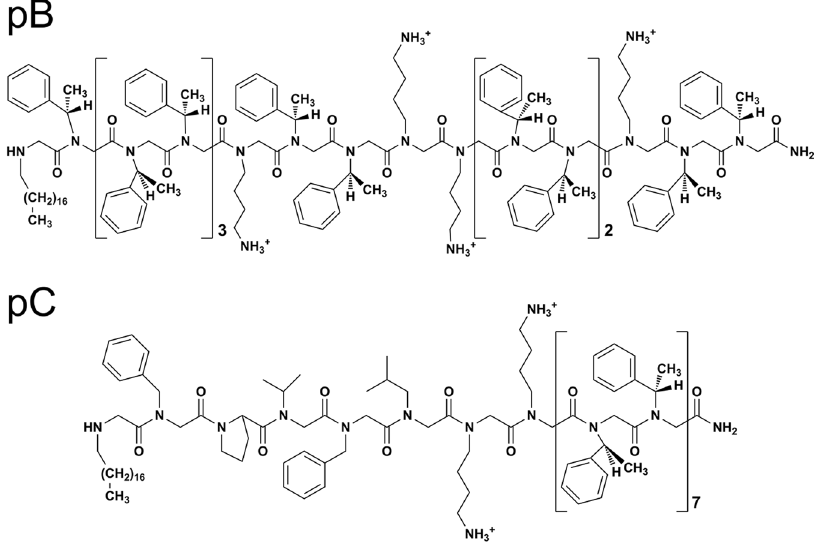
Figure 1. Chemical structures of peptoid-based mimics of SP-B ( pB ) 26 and SP-C ( pC ) 27 . The eight N -terminal residues of pC contain side chains that are analogous to SP-C 5–12 , and the remaining 14 aromatic hydrophobic residues form a helix that mimics the membrane spanning, hydrophobic helix of native SP-C. The N -terminal octadecyl amine of pC is a motif intended to mimic the post-translational modification of palmitoylated residues 5 and 6 in human SP-C. The mimic pB was designed to emulate the insertion region and helical amphipathic patterning of SP-B 1-25 , with the added feature of an N -terminal